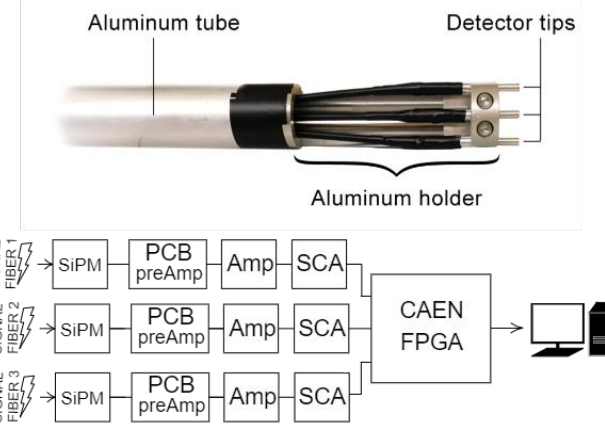
Fig. 3 - Fibers holder for measurements in SUR-100 (top) and read-out detection chain